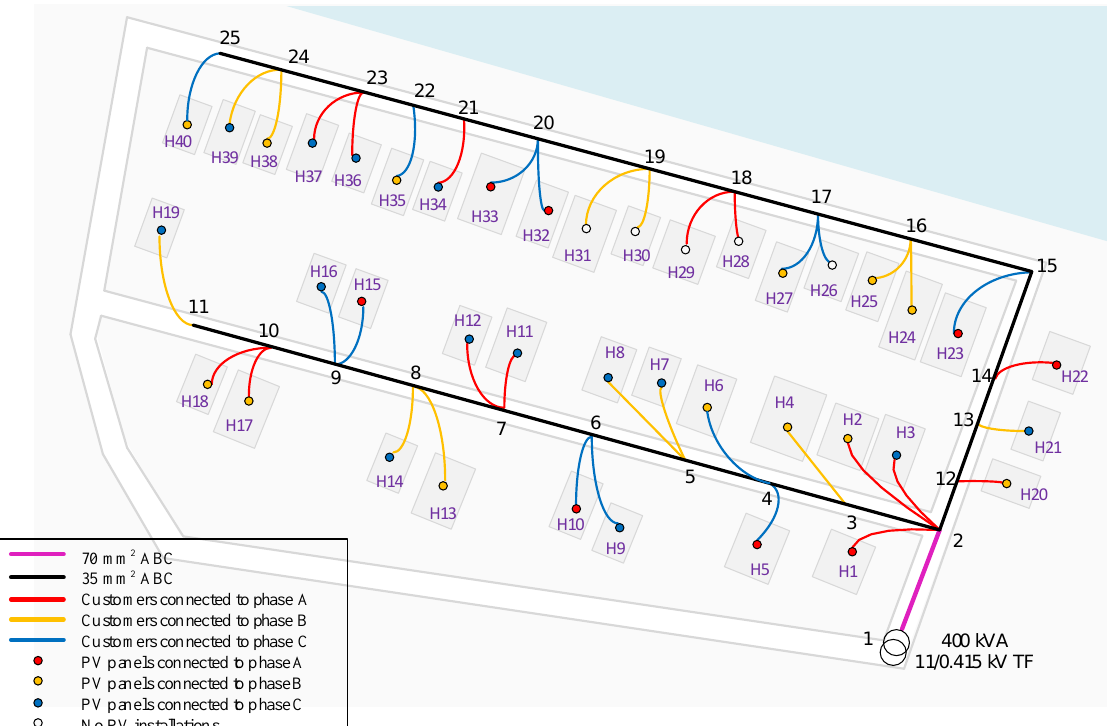
Figure 4. Single line diagram of the test network used for the